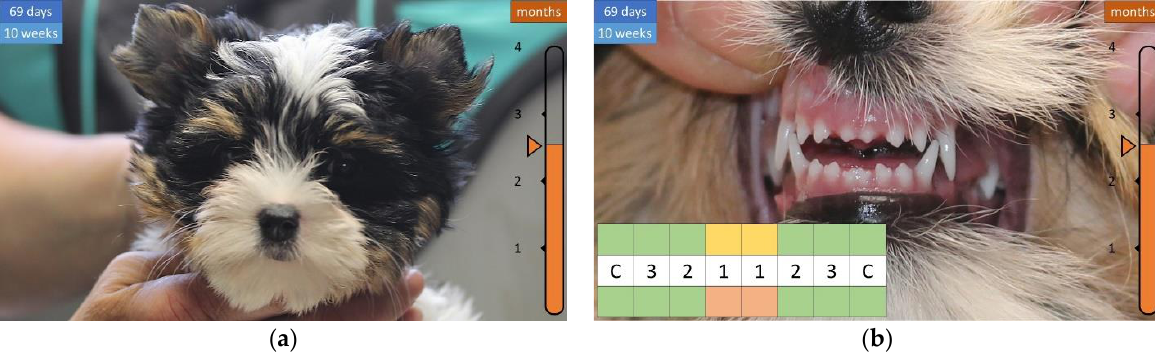
Figure 9. Development of the skull and teeth in a 10-week-old puppy. ( a ) Even more articulated head. ( b ) Teeth grew in a row except for the first incisors.